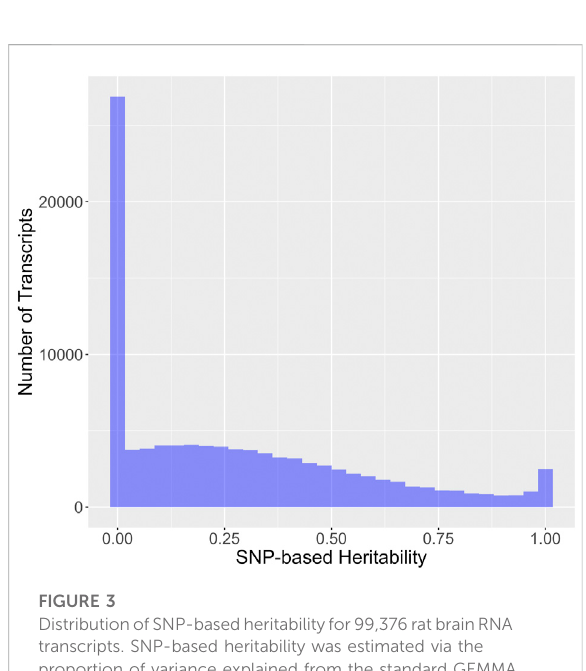
FIGURE 3 DistributionofSNP-basedheritabilityfor99,376ratbrainRNA transcripts. SNP-based heritability was estimated via the proportion of variance explained from the standard GEMMA modeling using strain